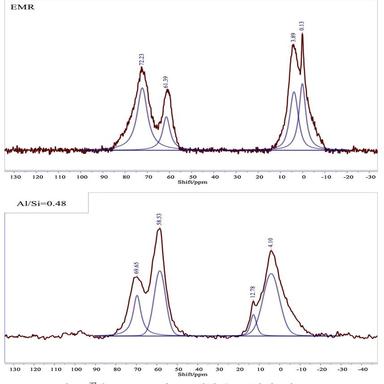
27Al NMR spectra of EMR and Al/Si = 0.48 hydrated pastes.